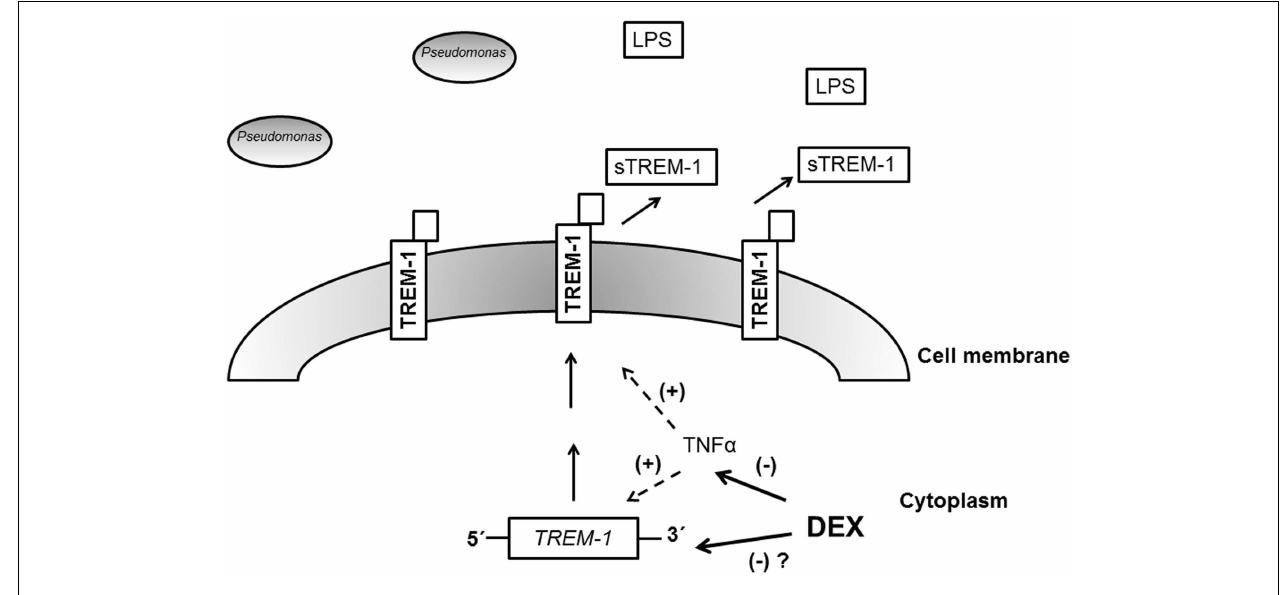
suppresses the activity ofTNF α , and sinceTNF α may have a positive effect on TREM-1 expression, DEX indirectly inhibitsTREM-1 expression.We speculate that DEX may also directly down-regulate TREM-1 gene expression, resulting in reduced production of membrane-boundTREM-1 and